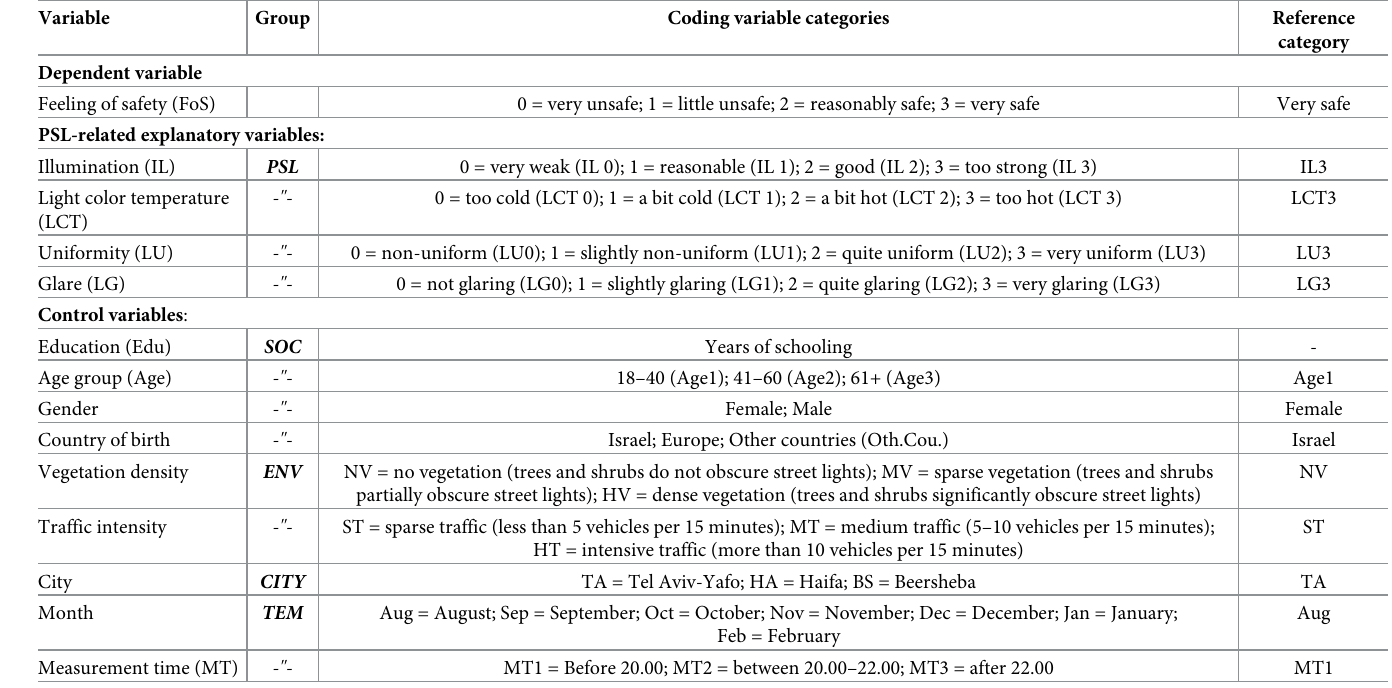
Table 1. Research variables, their reference categories and